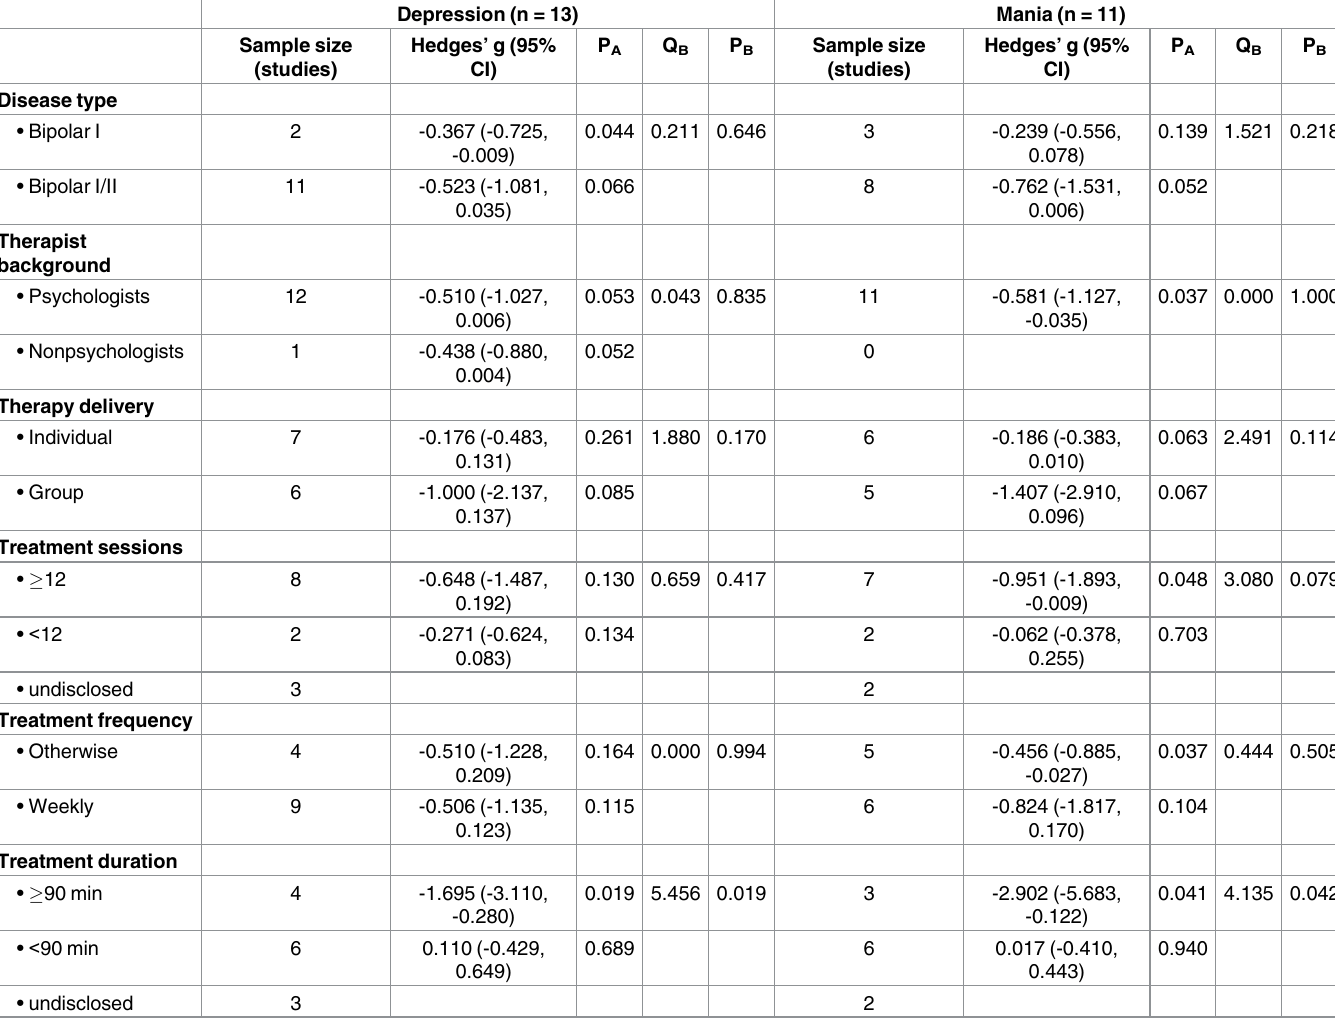
Table 3. Subgroup analysis of cognitive behavioral therapy for patients with bipolar disorder: Depression and